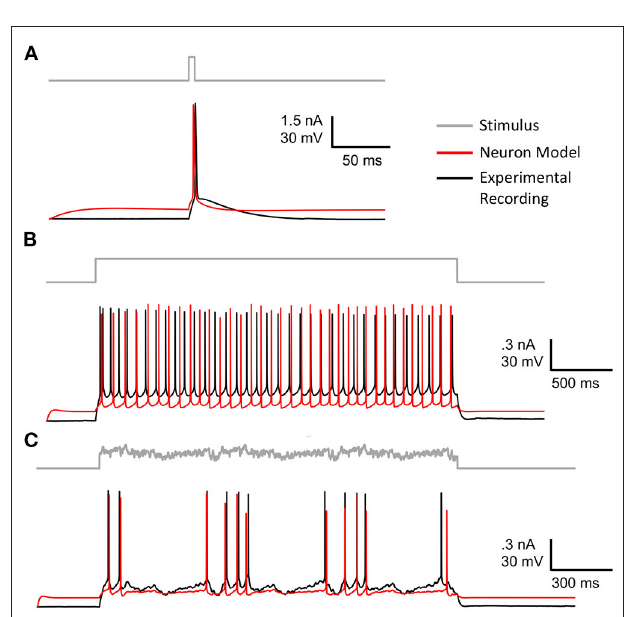
FIGURE 6 | Best fitted model after 50 generations of EA using 8 stimuli and 20 score functions (red) plotted against experimental data (black). (A) Long square stimulus. (B) Short square stimulus. (C) Noisy stimulus. The remaining stimuli and scores are shown in Supplementary Figure 5 and Supplementary Table 1 ,